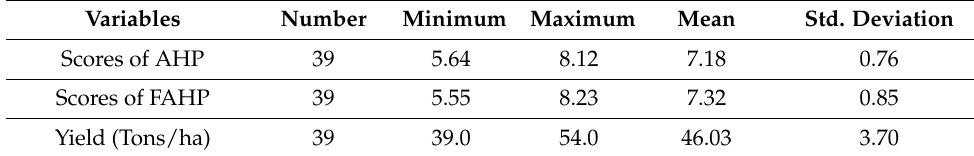
Table 4. Descriptive Statistics of selected